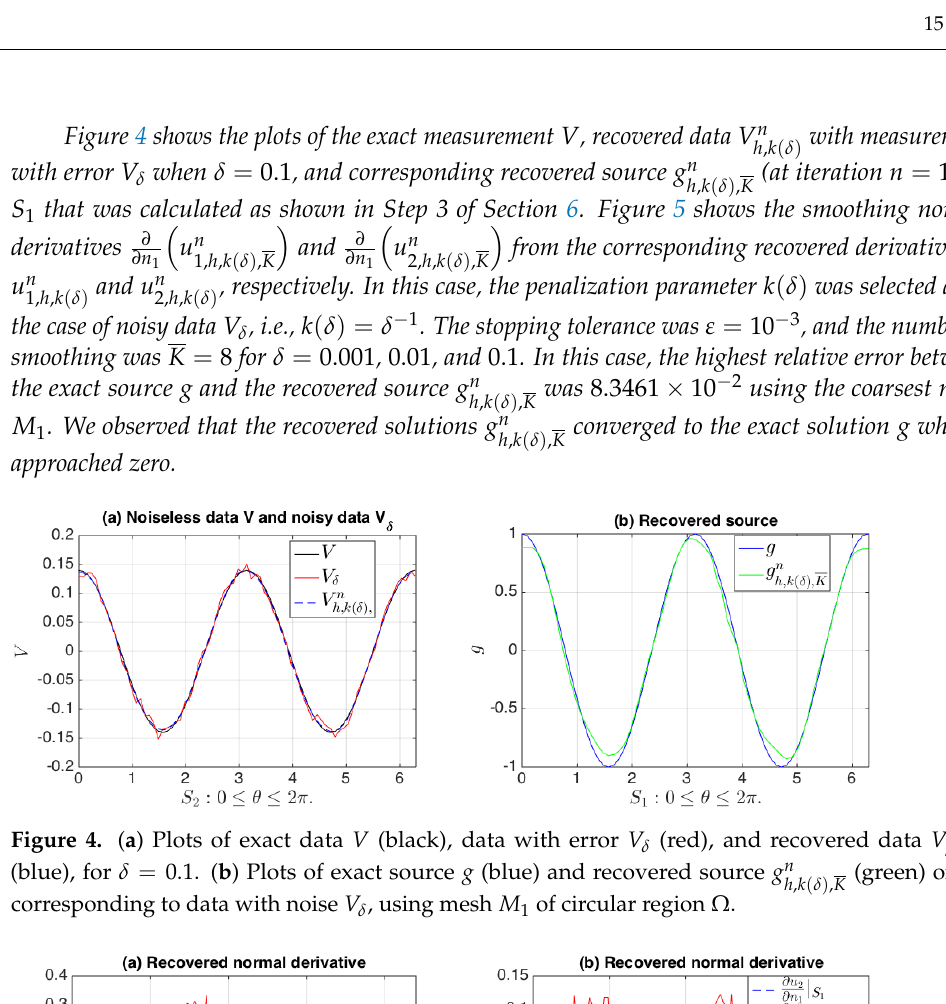
h , k ( δ ) (green) on S 1 , h , k ( δ ) , K